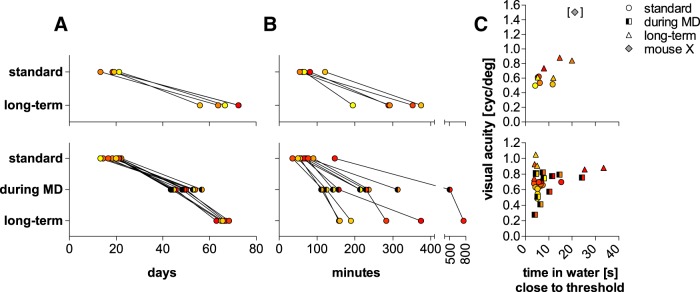
Training time in the VWT and correlation with VA. Time required to finish the different episodes of VWT training in (A) days and (B) minutes of the VWT/no-MD (upper row, n = 5) and VWT/MD(-reopening) group (lower row, n = 11 for standard and VA during MD, n = 6 for long-term VA after MD reopening). Individual data points are color-coded as introduced in Figure 6. C, Correlation of time required per correct trial near the break (spatial frequency of the break and two frequency steps below) and VA.